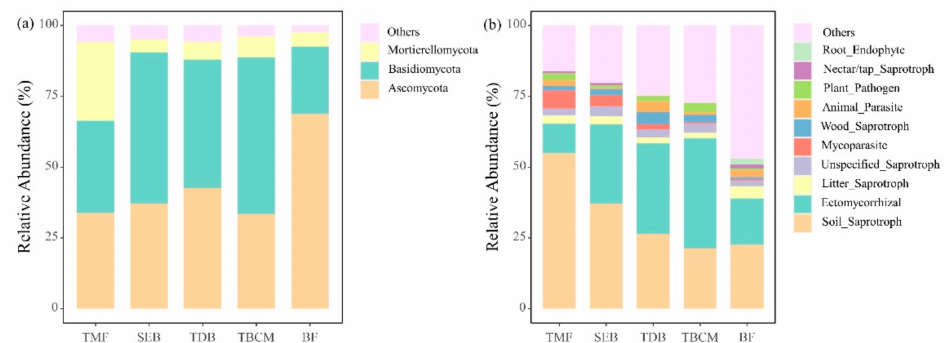
Figure 2. The average relative abundance (%) of fungal taxa at the phylum level ( a ) and the average relative abundance (%) of functional groups ( b ) in control treatments. TMF: tropical montane rain forest, SEB: subtropical evergreen broadleaved forest, TDB: temperate deciduous broadleaved forest, TBCM: temperate broadleaved and conifer mixed forest, BF: boreal